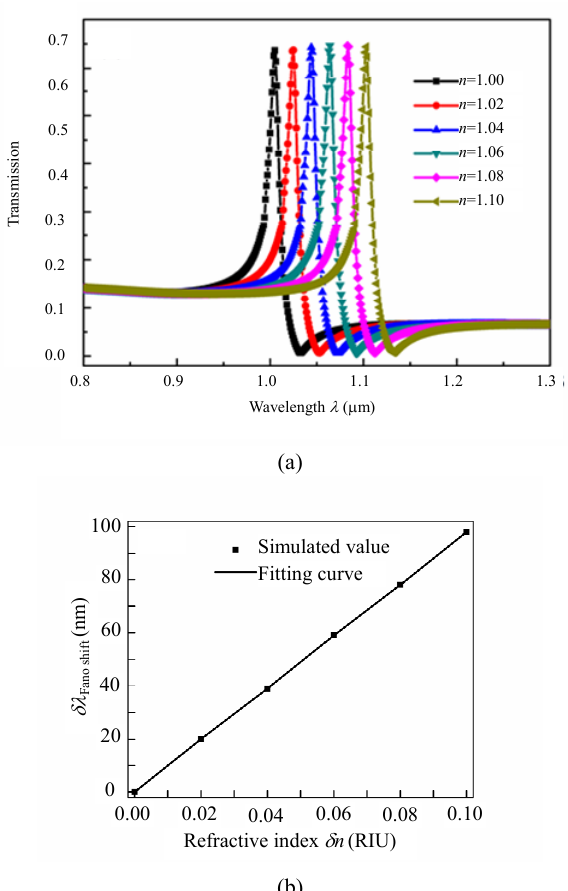
Fig. 3 Transmission spectra of the MIM waveguide coupled with two rings and rectangular cavities with (a) different refractive indexes n and (b) shift in the Fano resonance peak as a function of refractive index δ n . Here, r = r ′ = 115 nm.